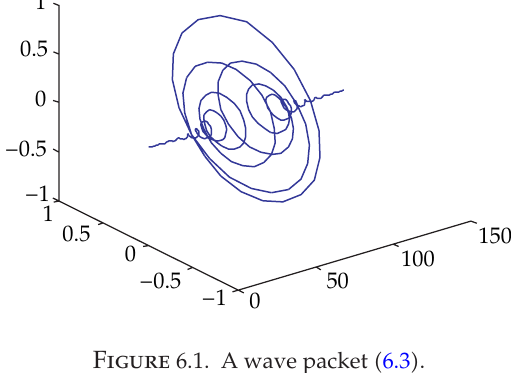
Figure 6.1 . A wave packet ( 6.3 )